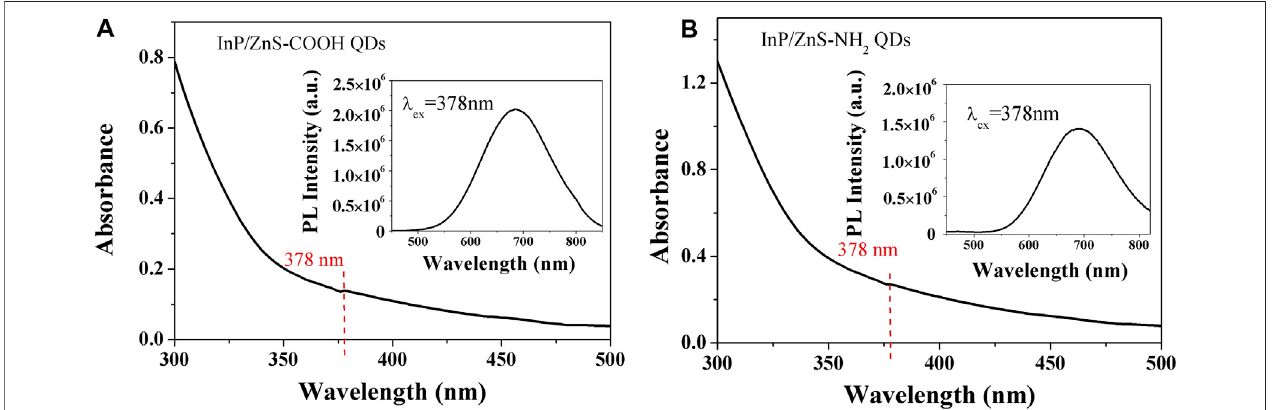
FIGURE 2 | Absorption spectra and photoluminescence spectra of InP/ZnS QDs coated with carboxyl (A) and amino (B) groups.